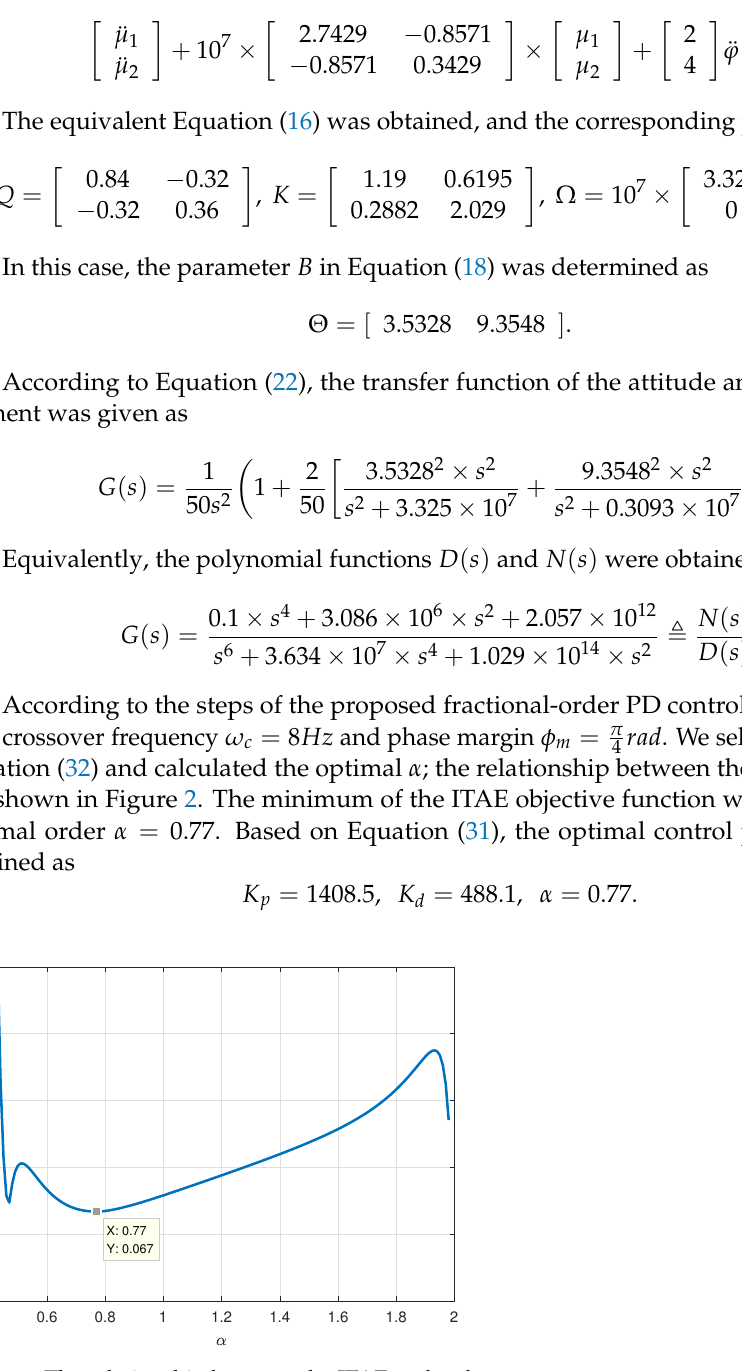
Figure 2. The relationship between the ITAE and order α